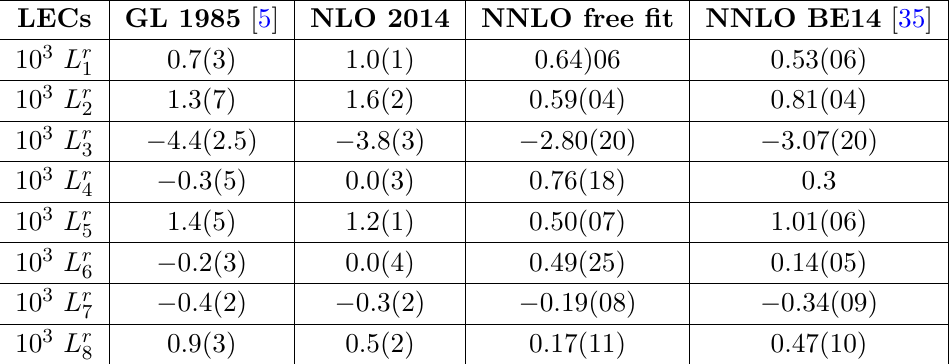
Table 3 . Various fits for NLO LECs L r